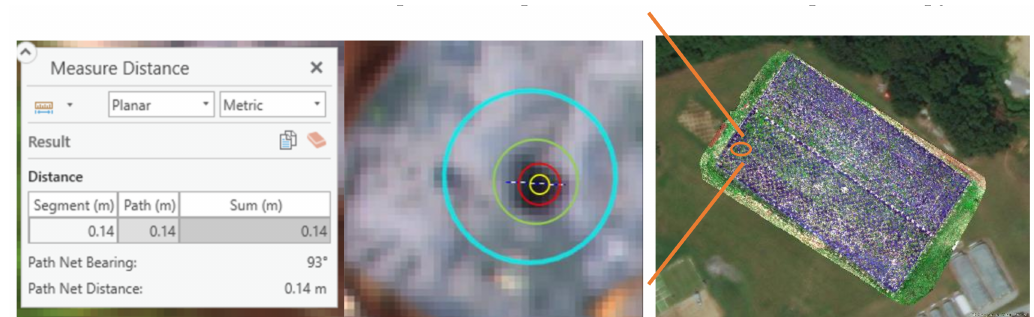
Figure 8. Comparison between 40 cm (blue), 20 cm (green), 10 cm (red), and 5 cm (yellow) buffer size over a single plant. Minimal canopy size in the field was ~14 cm (represented by the dark green footprint underneath the four